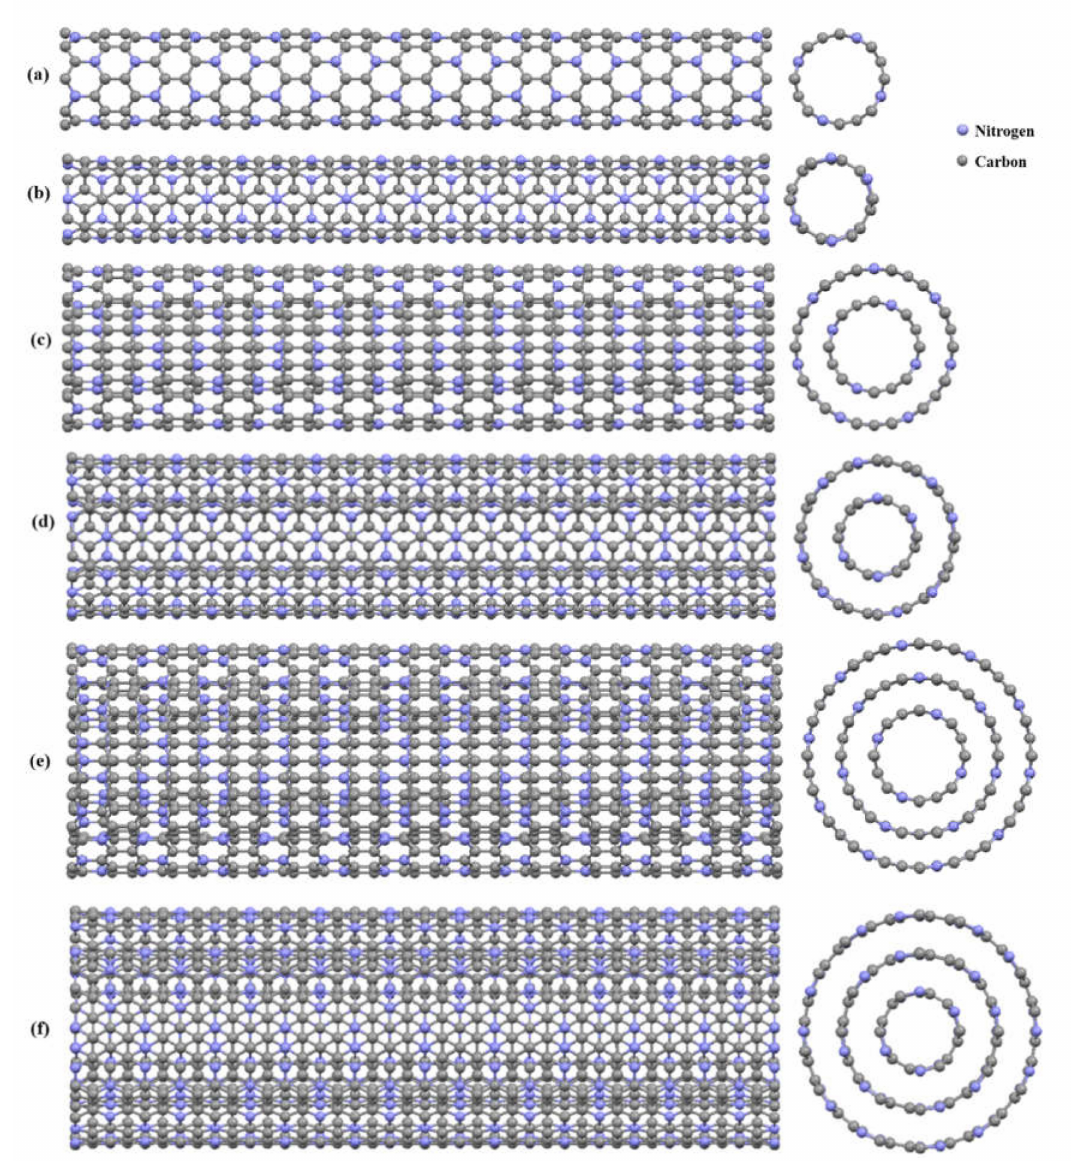
Figure 1. Schematic (side and cross-sectional) views of the modeled C 3 N nanotubes (C 3 NNTs): ( a ) (8,0) zigzag single-walled C 3 NNTs (SWC 3 NNT), ( b ) (4,4) armchair SWC 3 NNT, ( c ) ((8,0),(12,0)) zigzag double-walled (DWC 3 NNT), ( d ) ((4,4),(8,8)) armchair DWC 3 NNT, ( e ) ((8,0),(12,0),(20,0)) zigzag triple-walled (TWC 3 NNT), and ( f ) ((4,4),(8,8),(12,12)) armchair TWC 3 NNT.